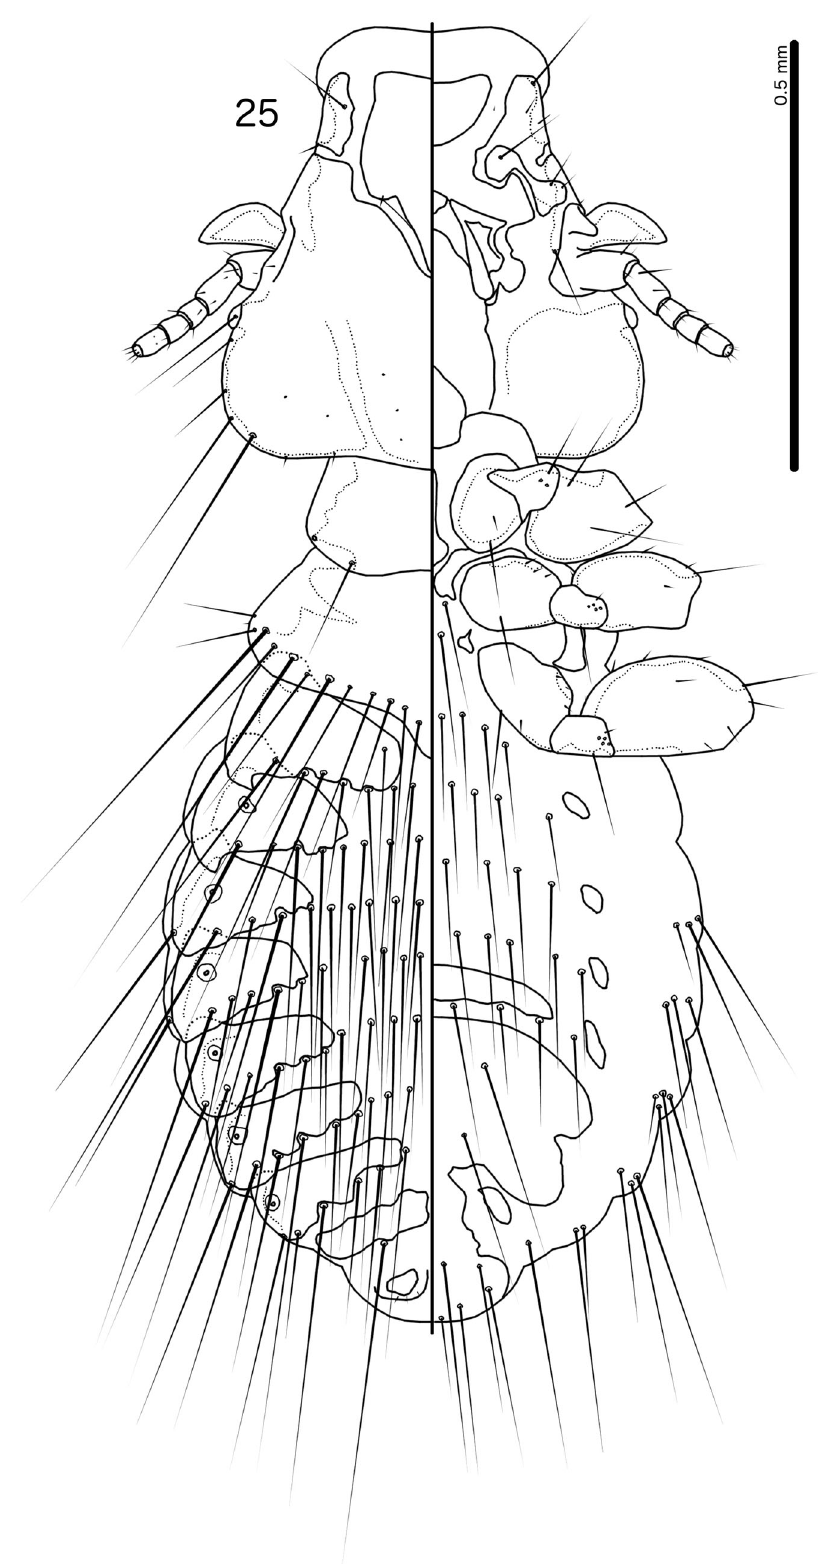
Fig. 25. Philopterus trepostephanus sp. nov. ex Tephrodornis virgatus fretensis Robinson & Kloss, 1920, male habitus, dorsal and ventral